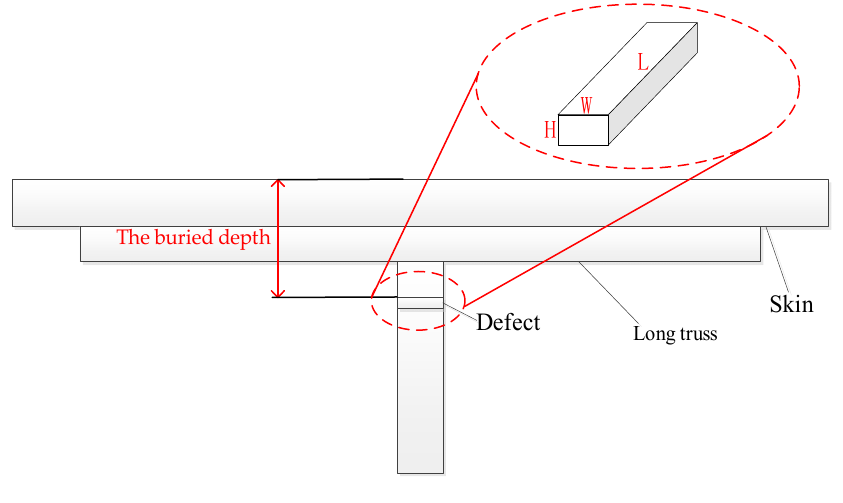
Figure 15. Crack Figure 15. Crack schematic.